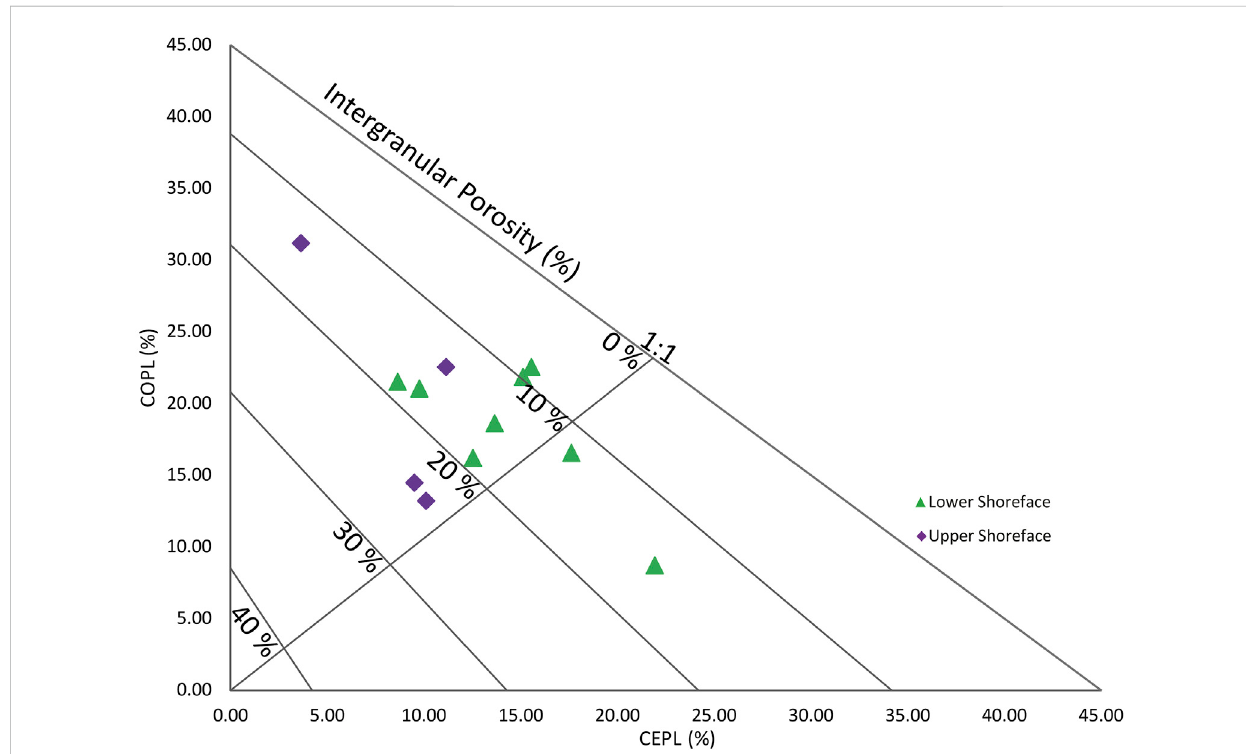
FIGURE 8 Plotofcompactional porosity loss(COPL) againstcementational porosity loss (CEPL)showingthatcompaction isthemaindriver forporosity loss in the studied